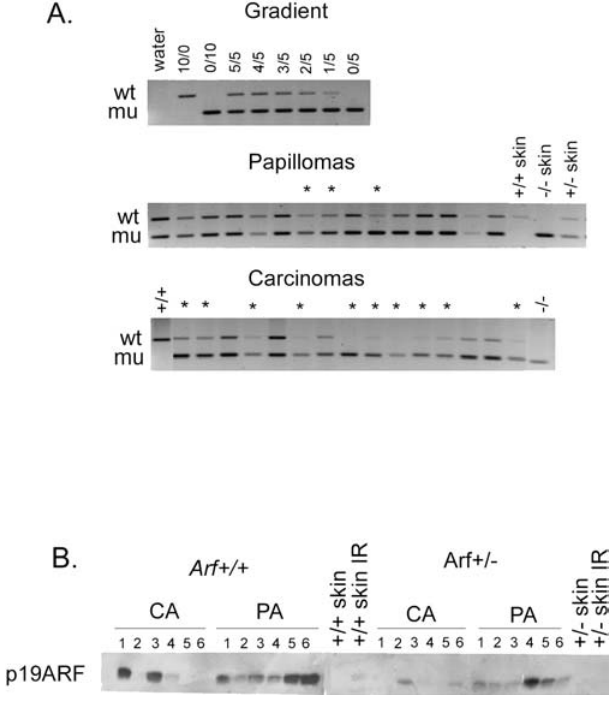
Figure 4. LOH of Wild-Type p19 Arf Allele in p19 Arf þ / (cid:1) Tumors (A) LOH analysis by semiquantitative PCR of the wild-type p19 Arf allele in p19 Arf þ / (cid:1) papillomas and carcinomas. Gradient made from kidney DNA used for quantitation of wt/mu ratio (top row). wt, wild- type allele; mu, knockout allele; asterisk, loss or reduction of p19 Arf wild-type band. (B) Western blot analysis of nuclear lysates from papillomas (PA) and carcinomas (CA) from p19 Arf þ / þ , p19 Arf þ / (cid:1) , and p19 Arf (cid:1) / (cid:1) mice. DOI: